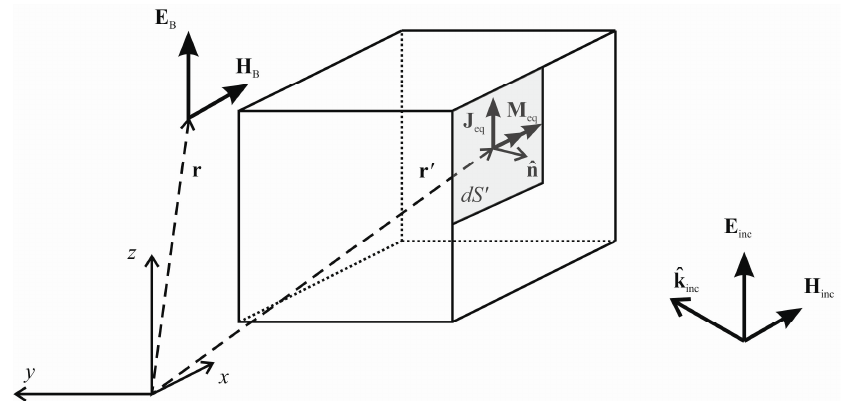
Figure 1. The common PO approach. The incident plane wave fields E inc and H inc result into surface equivalent currents J eq and M eq on the illuminated outer surface of the object. In turn, these currents provide scattered fields resulting into the blockage fields behind the object and cause the final coherent fields behind the object to be E B and H B from Equations (3) and (4).